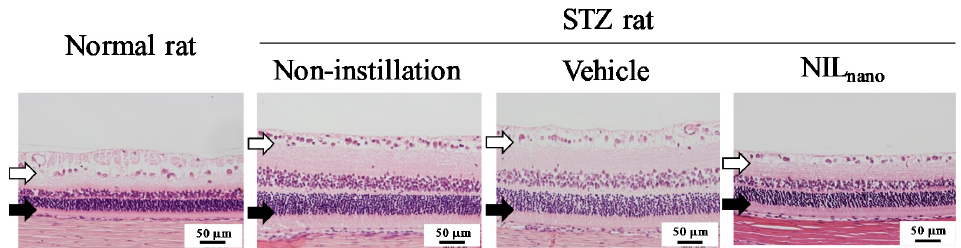
Figure 5. Preventive effect of NIL nano on hypertrophic retina of STZ rats. Bars indicate 50 μ m. One percent NIL was instilled for two weeks (twice a day, 9:00 a.m. and 7:00 p.m.). Open arrows, retinal ganglion cells. Closed arrows, outer granule layer. Normal rat, non-instilled normal rats; Non-instillation, non-instilled STZ rats; Vehicle, vehicle-instilled STZ rats; NIL nano , NIL nano -instilled STZ rats. The hypertrophy seen in STZ rat retinas was attenuated by the instillation of NIL nano . Table 1. Effect of NIL nano on the retinal thickness of rats two weeks after the injection of excessive streptozotocin. Group Normal Rat